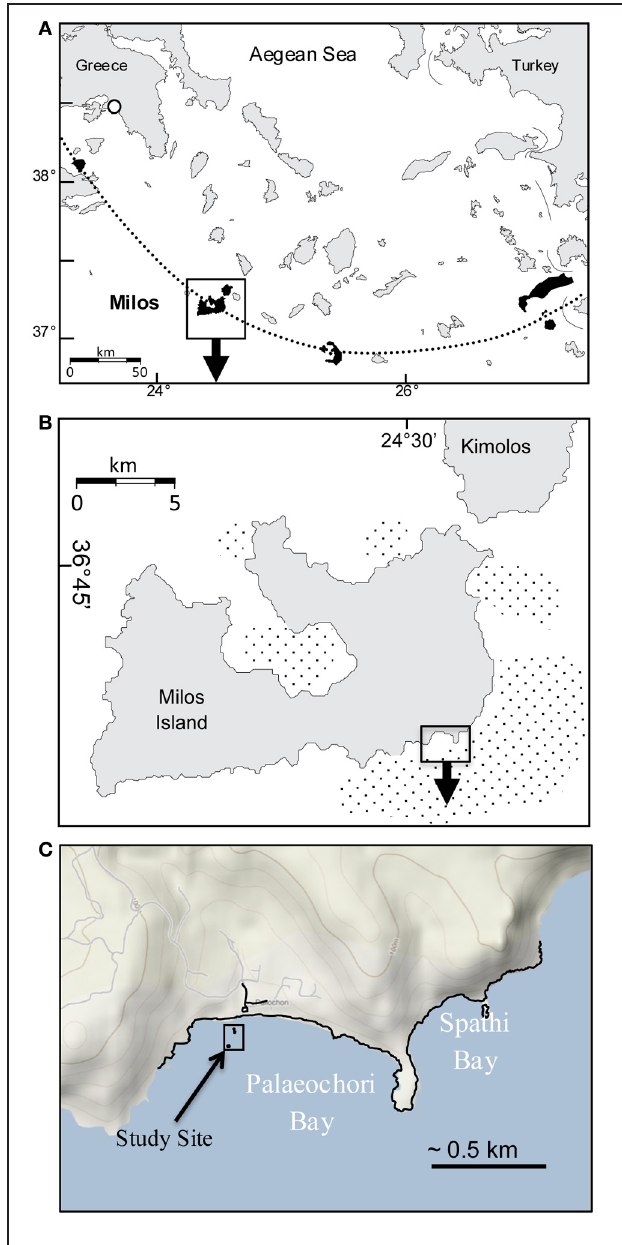
FIGURE 1 | (A) Location of Milos Island (box) and other calc-alkaline volcanoes (shaded) along the Aegean island arc (dotted line). (B) Milos Island and the location of Palaeochori and Spathi Bays (box). Stippled offshore areas around the island are mapped gas emissions by echo sounding (Dando et al., 1995). (C) Location of our study site (box) in Palaeochori Bay.